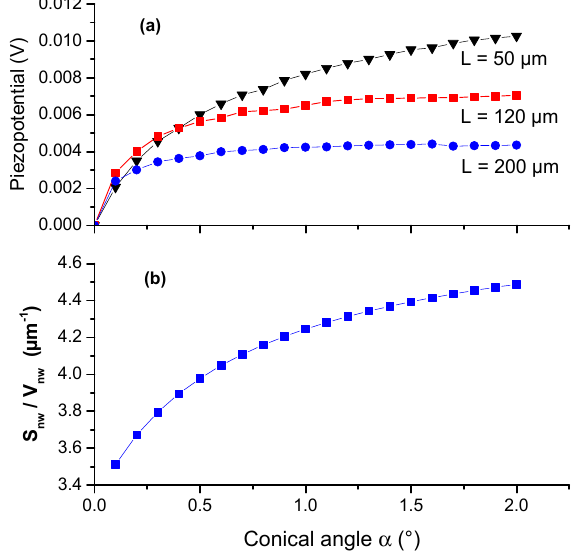
Figure 9. ( a ) Piezo-potential evolution as function of the conicity angle α for wires with L = 50, 120, 200 µ m and and R top = 700 nm. ( b ) The related variation of the surface over volume